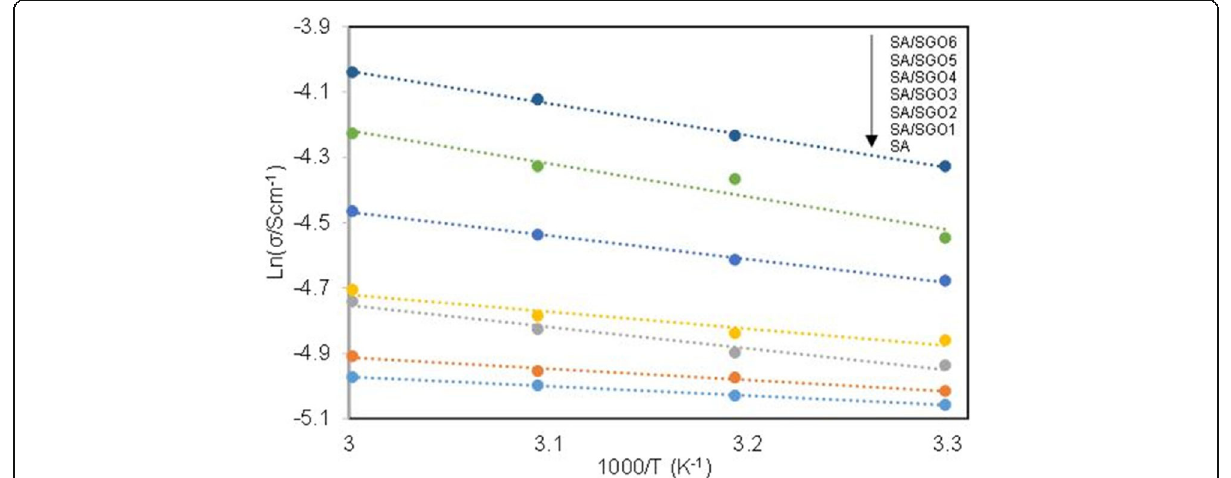
Fig. 11 ln σ vs. 1000/T plot for the cross-linked QAPVA membranes, the lines indicate the linear regression